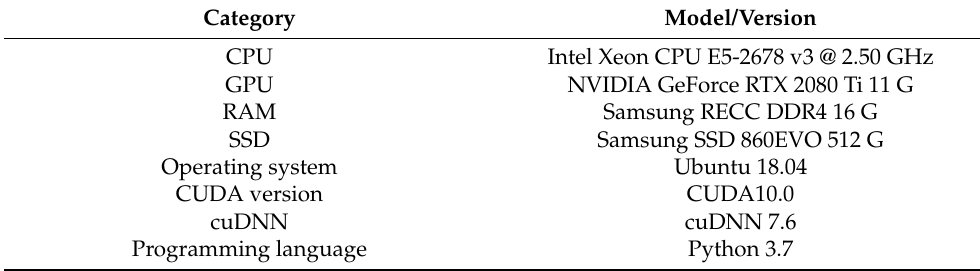
Table 2. The configuration of the experimental